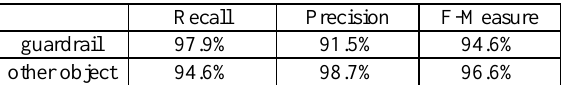
Figure 22. Unit shape of guardrail consisting of beams